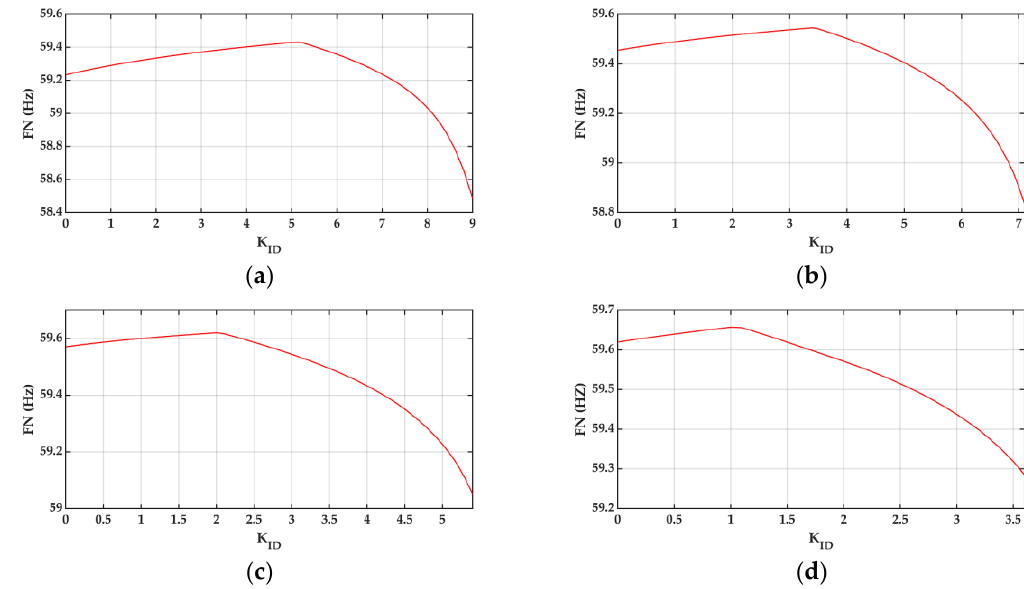
Figure 6. E ff ect of integral controller gain K ID on frequency nadir under di ff erent values of K PD Figure 6. Effect of integral controller gain K ID on frequency nadir under different values of K PD ( a ) ( a ) K PD = 5, ( b ) K PD = 10, ( c ) K PD = 15, ( d ) K PD = 20. K PD = 5, ( b ) K PD = 10, ( c ) K PD = 15, ( d ) K PD = 20.